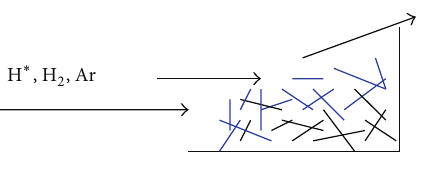
Figure 4: GNPs reduction treatment under continuous flow of